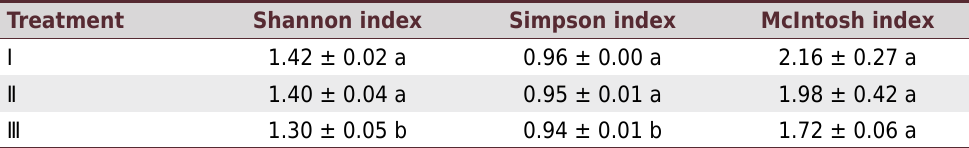
Table 3. Soil microbial communities diversity indices of 72 h Treatment